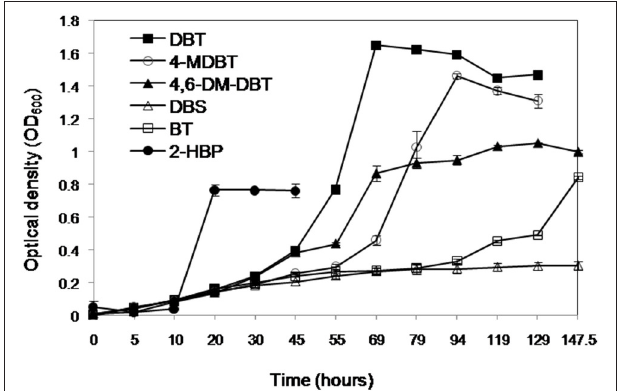
FIGURE 2 | Growth of the AK6 mixed culture on different organosulfur compounds as sulfur sources in the presence of glucose as a carbon source. Growth on 2-HBP as a carbon source in the presence of inorganic sulfate as a sulfur source is also shown.